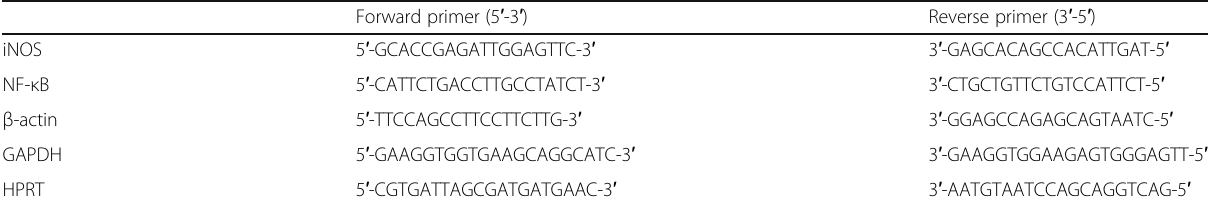
Table 1 Primer sequences of inducible nitric oxide synthase (iNOS) and nuclear factor kappa-light-chain-enhancer of activated B cells (NF-kB) used in the quantitative real time PCR (qRT-PCR) assay. Beta-actin ( β -actin), hypoxanthine phosphoribosyltransferase (HPRT) and glyceraldehyde 3-phosphate dehydrogenase (GAPDH) were used as housekeeping genes for normalization of the iNOS and NF-kB gene